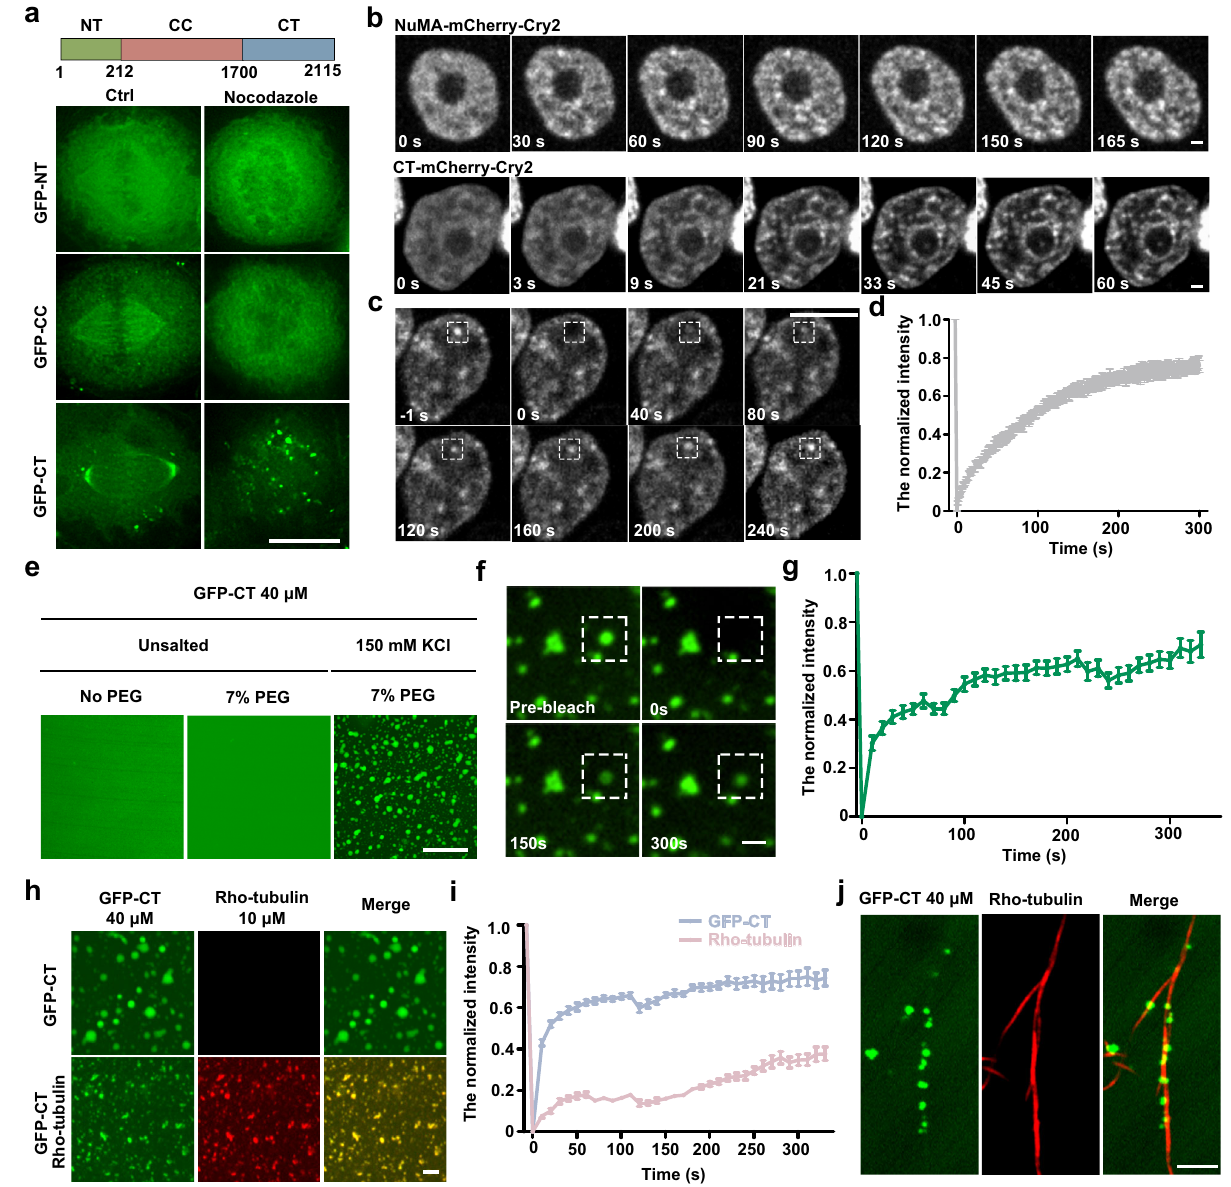
Fig. 3 C-terminus of NuMA is required for mitotic phase separation. a Schematic diagram and immuno fl uorescence images of three domains of NuMA expressed in mitotic HeLa cells without (Ctrl) or with treatment of nocodazole. b Time-lapse images of HEK293T cells expressing full-length NuMA or CT mutant fused with mCherry-Cry2. The cells were subjected to laser excitation and images were captured every 3 s. Scale bar, 2 μ m. c , d Time-lapse images ( c ) and quanti fi cation ( d ) of FRAP of CT droplets in OptoDroplet system (mean ± SEM, n = 12 droplets). e Confocal microscopic images of GFP-CT droplets in vitro. GFP-CT were incubated in phase separation assay buffer at the indicated conditions and visualized by confocal microscopy. f , g Time- lapse images ( f ) and quanti fi cation ( g ) of FRAP of GFP-CT droplets phase-separated in vitro (mean ± SEM, n = 13 droplets). Scale bar, 2 μ m. h Confocal microscopic images of GFP-CT and Rho-tubulin droplets phase-separated in vitro. GFP-CT were incubated with Rho-tubulin in phase separation buffer at the indicated conditions, followed by visualization with confocal microscopy. Scale bar, 2 μ m. i Quanti fi cations of FRAP of GFP-CT/Rho-tubulin droplets phase-separated in vitro (mean ± SEM, n = 10 droplets per sample). j Microscopic images of GFP-CT droplets binding to taxol-stabilized microtubules in vitro. Taxol-stabilized microtubules were added to GFP-CT droplets in phase separation buffer and visualized with confocal microscopy. Scale bars, 10 μ m unless speci fi ed